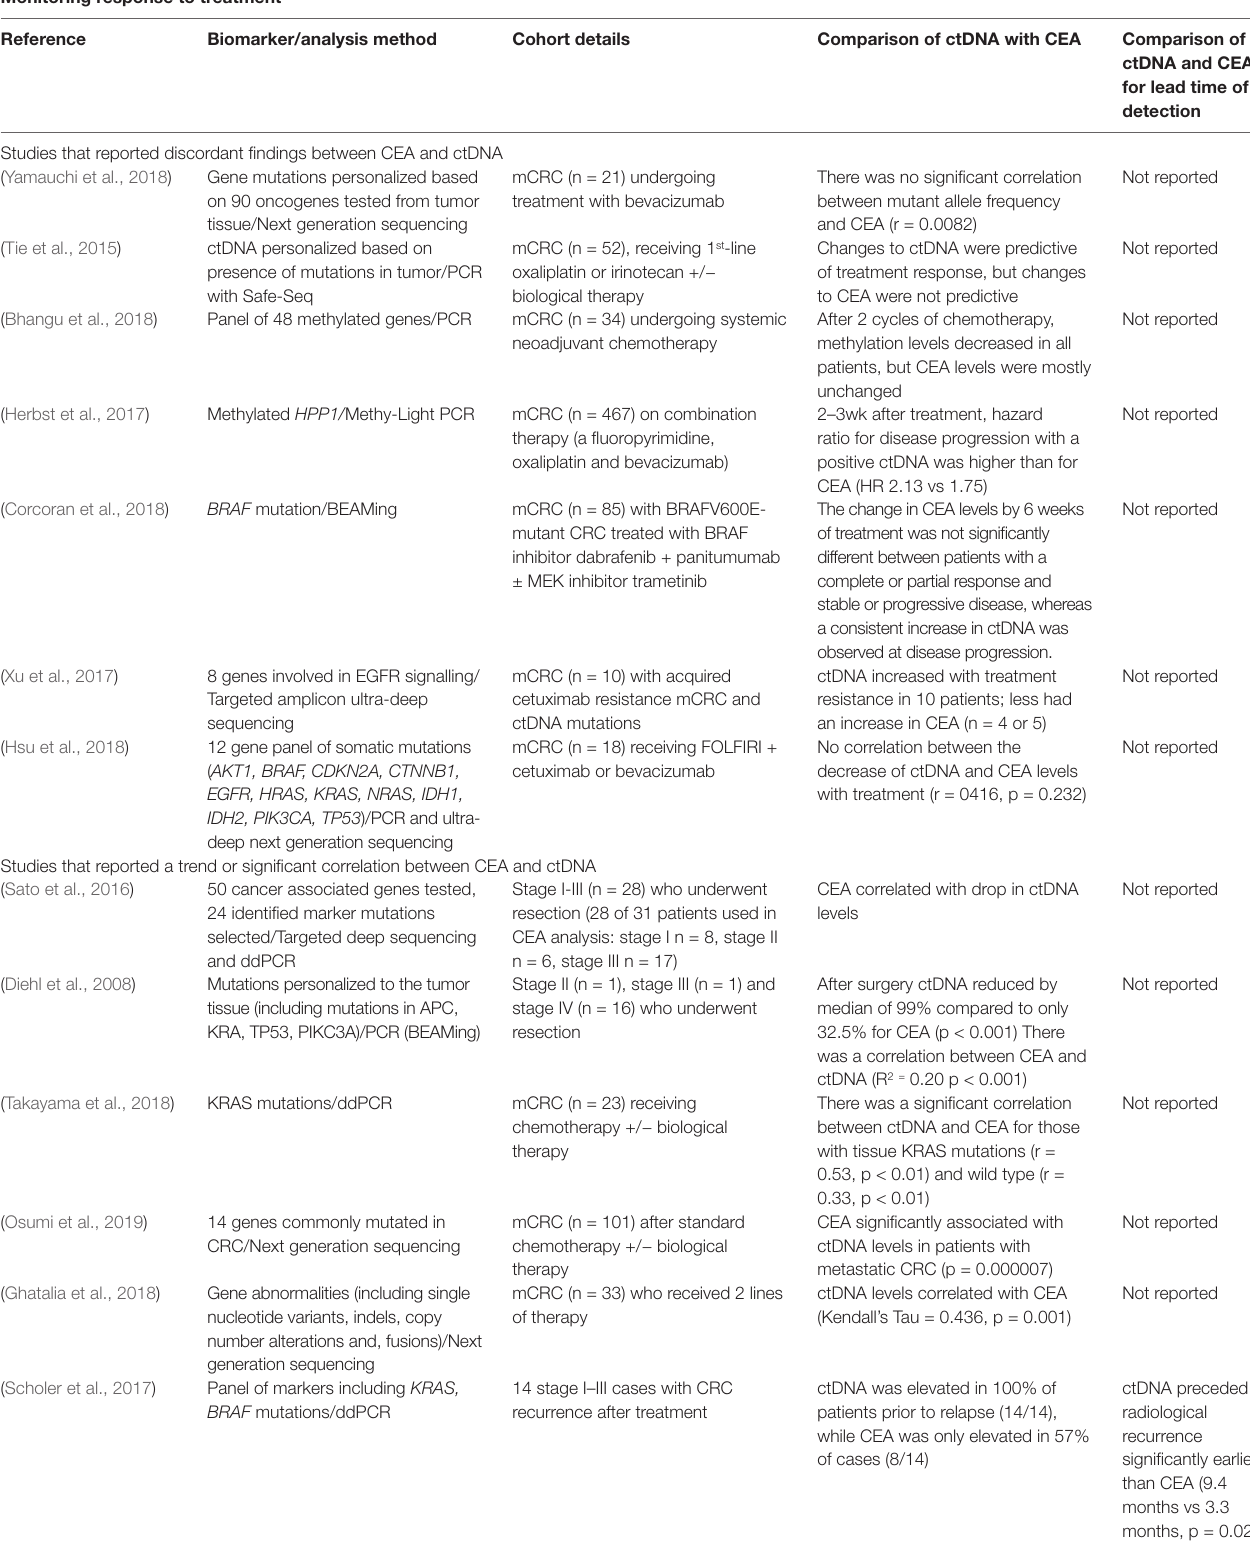
TABLe 3 | Comparison of circulating tumor DNA (ctDNA) and carcinoembryonic antigen (CEA) blood